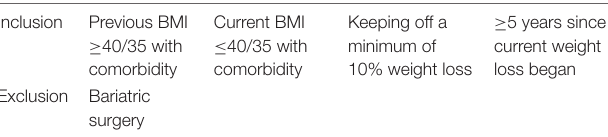
TABLE 2 | Study inclusion/exclusion